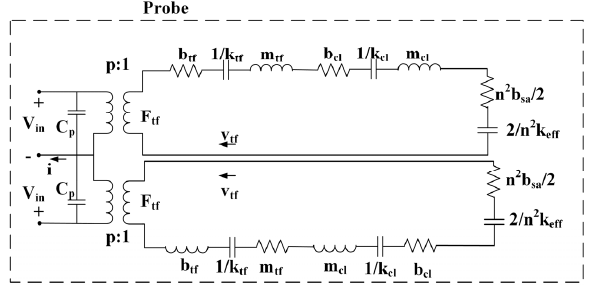
Figure 9. The transformation from sample to probe.